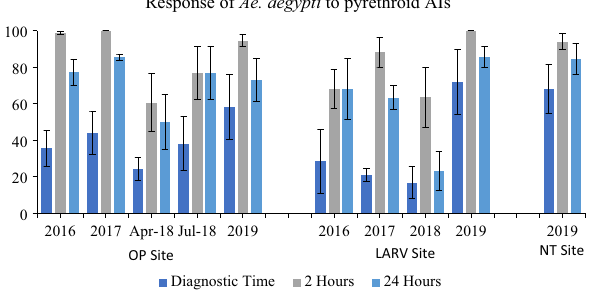
Fig. 3 Mean response and 95% confidence interval of Pasco County Aedes aegypti field populations in response to organophos- phate active ingredients in the CDC bottle bioassay. For each popu- lation and each time point, the percent mortality at the diagnostic time, at 2 h, and 24 h is displayed